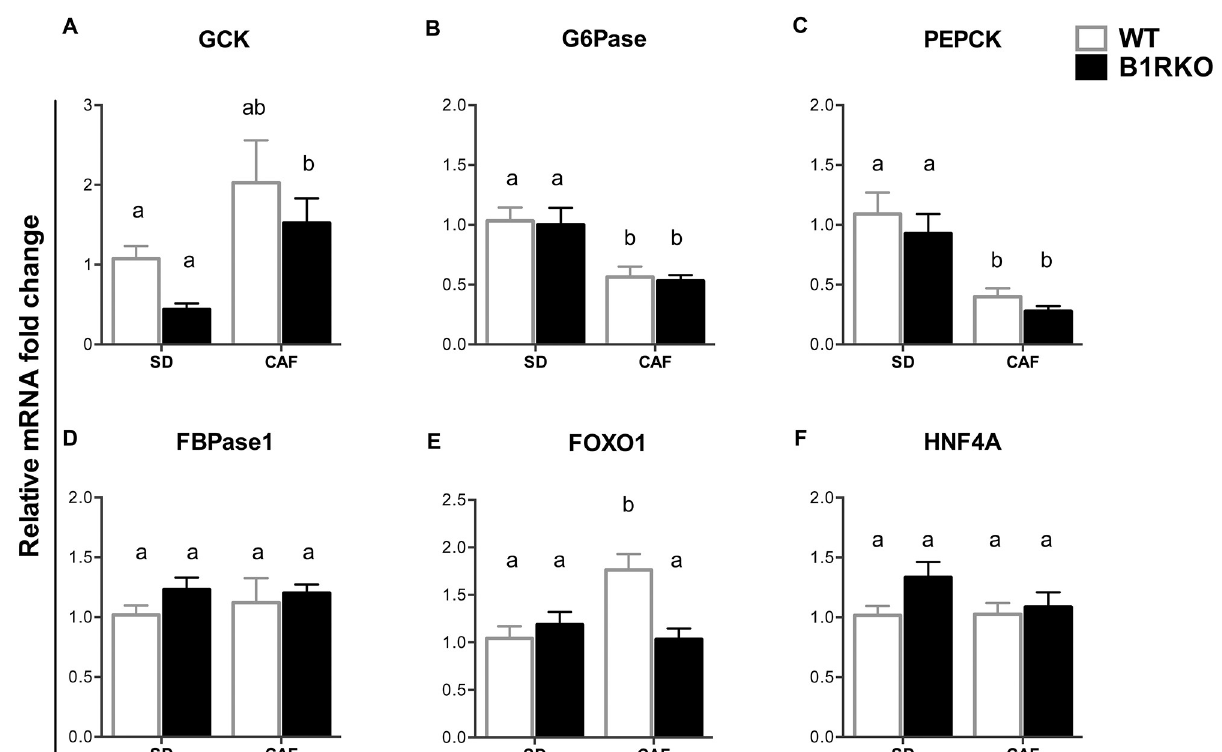
Fig 5. Hepatic expression of glycolysis and gluconeogenesis regulators. A) Glucokinase (GCK). B) Glucose-6-phosphatase (G6Pase). C) Phosphoenolpyruvate carboxykinase (PEPCK). D) Fructose-1,6-bisphosphatase 1 (FbP1). E) Forkhead box protein O1 (FOXO1). F) Hepatocyte nuclear factor 4 alpha (HNF4A). p < 0.05; comparing genotype (#) and diet ( � ); p-value by two-way ANOVA. P-value tested by two-way ANOVA followed by the Bonferroni post-hoc test. Different letters indicate differences in the post-hoc test. Data are expressed as mean ± SEM. WT, wild type; B1RKO, B1R knockout mice; SD, standard diet; CAF, cafeteria diet, n = 6.